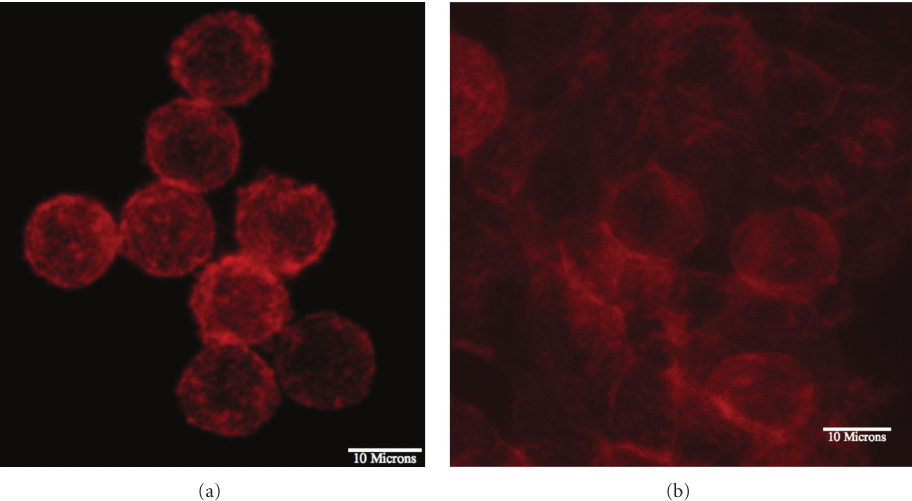
Figure 1: SW620 cells were seeded at di ff erent densities: 50 × 10 3 (a), and 250 × 10 3 cells/cm 2 (b). The lower seeding density (a) shows rounder cells with few cell-cell contacts. The greater seeding density allows for more cell-cell contact, creating a more epithelial state. Scale Bar = 10 μ